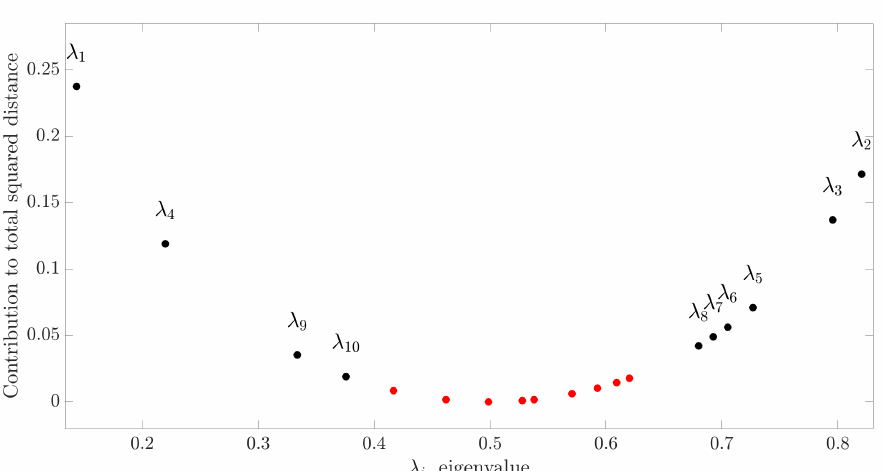
Figure 4. Contribution to the total squared Riemannian distance provided by the eigenvalues λ j corresponding to each spatial filter c j ( j = 1, . . . ,19) of the CSP matrix obtained for the generalized seizures trials classified as base and pre . Black and red dots identify the selected spatial filters and the discarded filters,